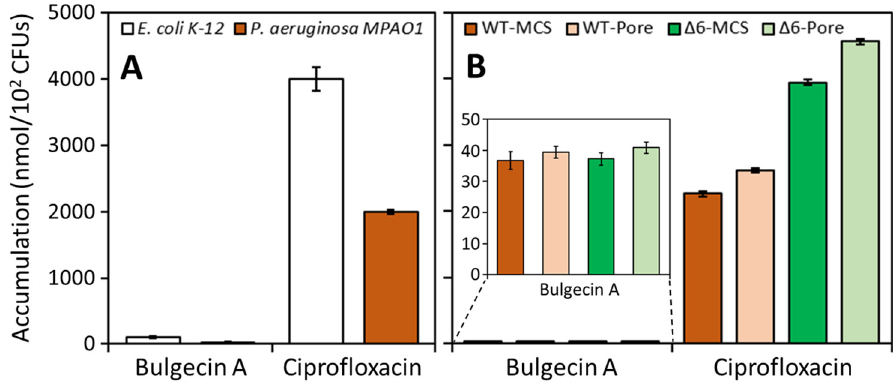
Figure 1. Accumulation of bulgecin A and ciprofloxacin. The accumulation was determined in the wild-type E. coli K-12 and P. aeruginosa MPAO1 ( A ), and in the wild-type P. aeruginosa PAO1 and its mutant P. aeruginosa strains ( B ). P. aeruginosa MPAO1 is the parental PAO1 strain for transposon insertion used in Manoil Lab at University of Washington. The determinations were performed in triplicate independently.